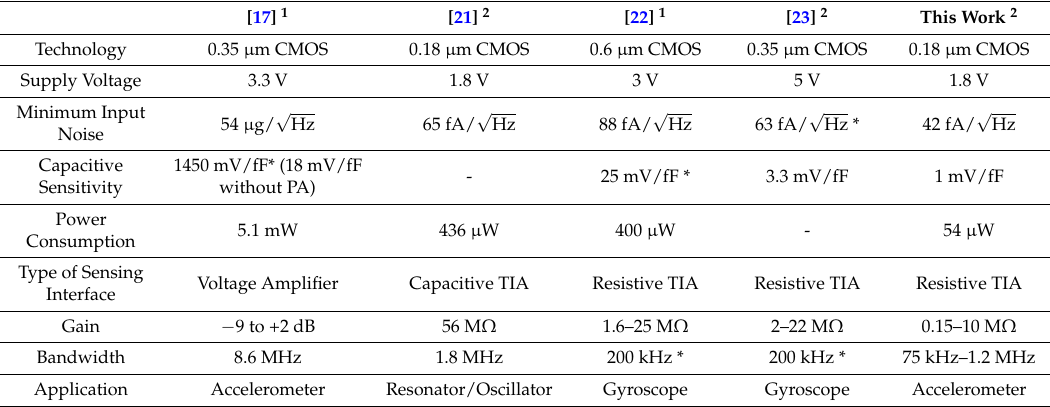
Table 2. Summary of the performance and comparison with recently published works.